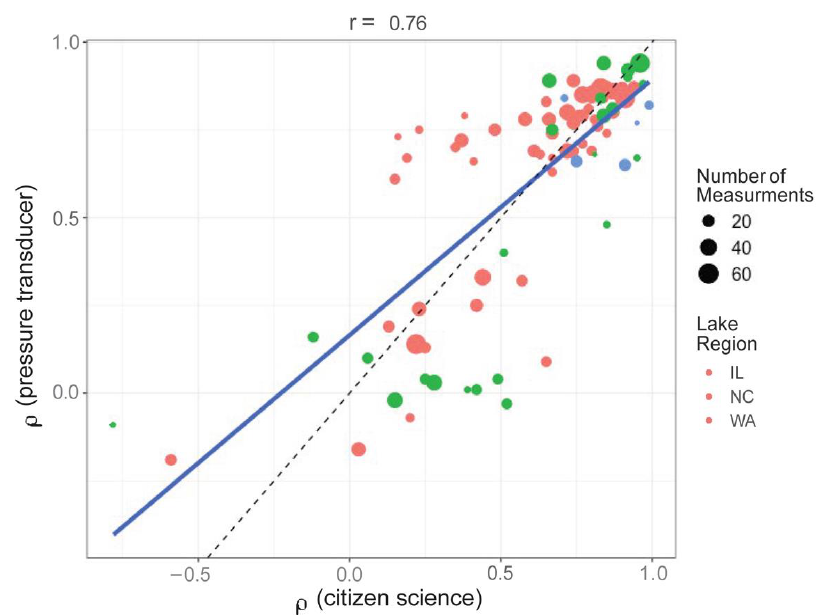
Figure 9. Correlation coefficients between lake pairs in a region of the citizen-scientist-based change in volume versus the correlation coefficients between lake pairs in a region of the pressure-transducer-based change in volume. A strong correlation between the two is seen. The dashed line is a one-to-one line and the blue line is the line of best fit.